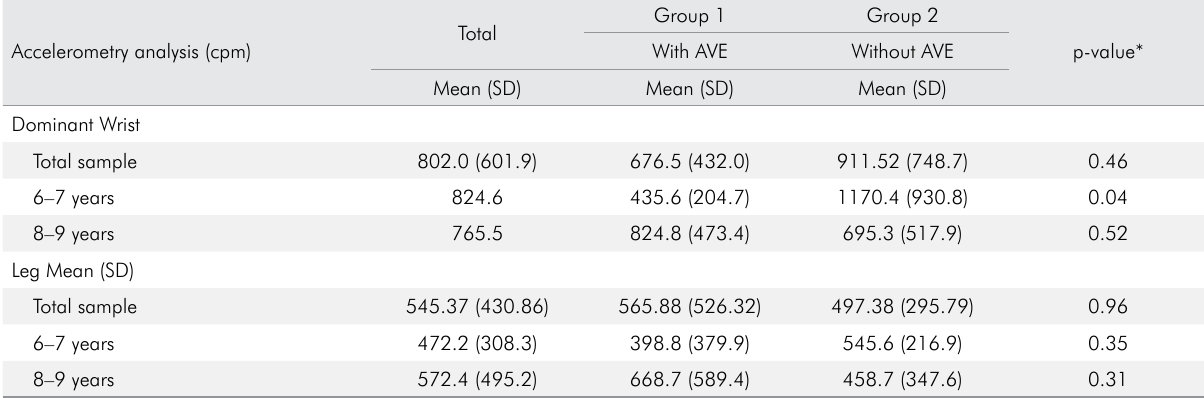
Table 5. Body movements (counts per minute measurement – cpm) measured by accelerometers during the dental visit according to the use of audiovisual eyeglasses (AVE) (n =